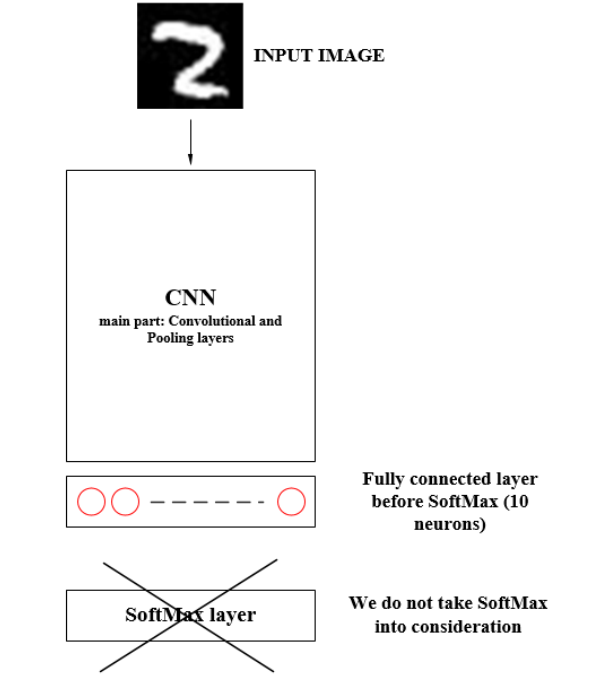
Figure 1. Schematic view of LeNet. We exclude SoftMax layer from further